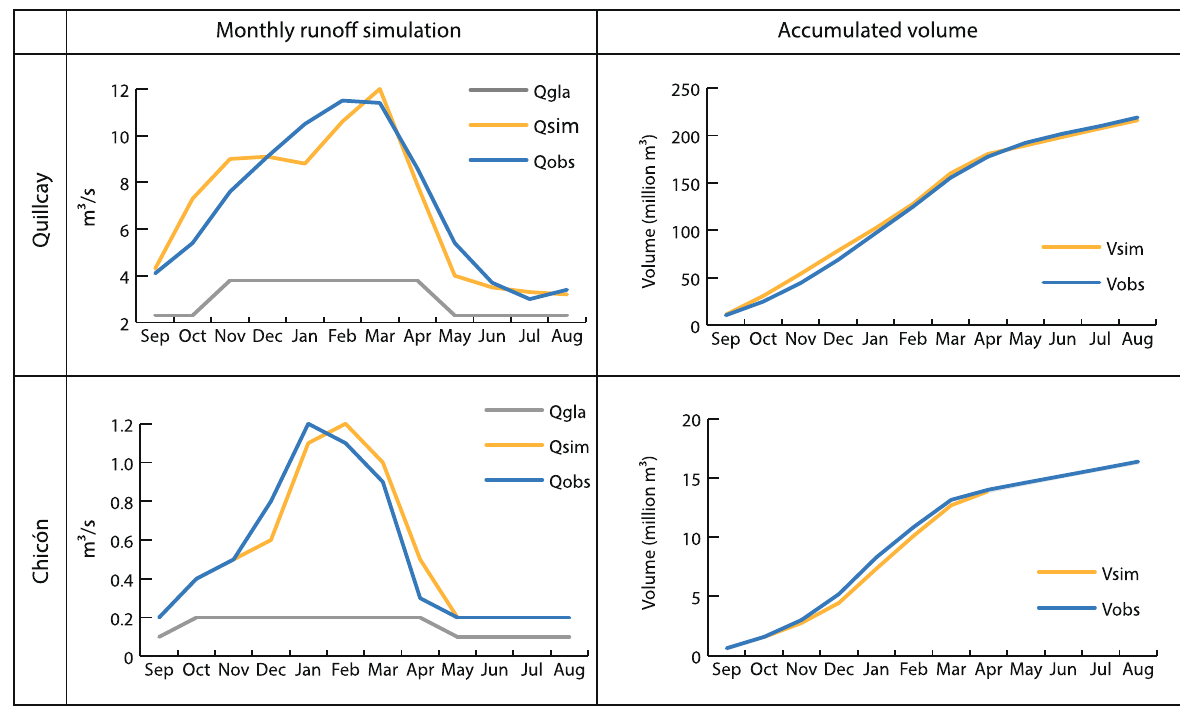
Fig. 4 Hydrological calibration for Quillcay (upper) and Chicón (lower): [left] comparison between Qobs (observed streamflow), Qsim (simulated streamflow) and Qgla (glacier runoff); [right] comparison of Vobs (accumulated volume from observed total streamflow) and Vsim (accumulated volume from simulated